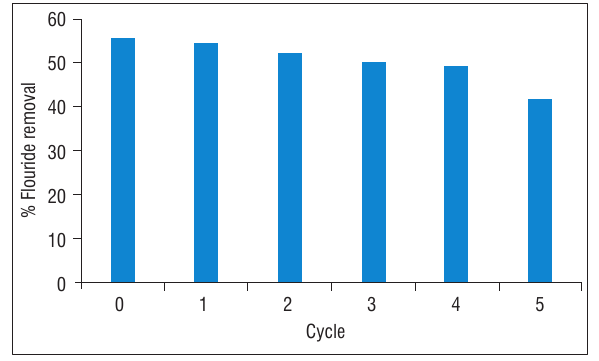
Figure 6: Percentage fluoride removal by smectite-rich clay soil in successive cycles (at 3 mg/L fluoride, 30 min contact time at 250 rpm and pH 5.54).